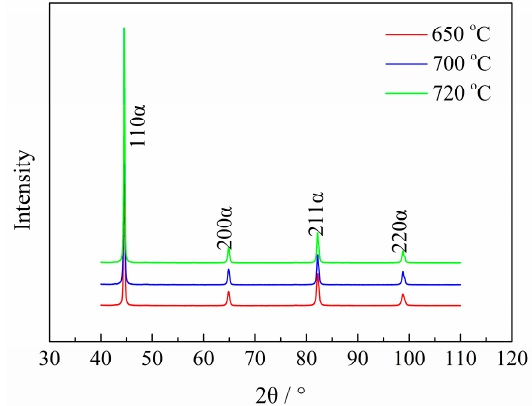
Figure 11. XRD patterns of Q&T–treated samples at differing T t .